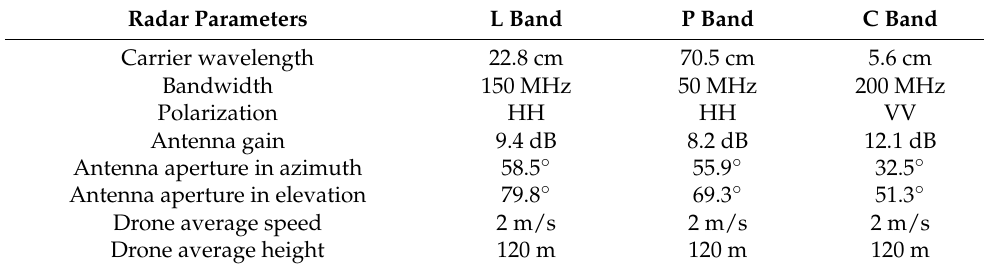
Table 1. Main radar acquisition parameters for the L, P, and C bands. Radar Parameters L Band P Band C Band Carrier wavelength 22.8 cm Bandwidth 150 MHz Polarization